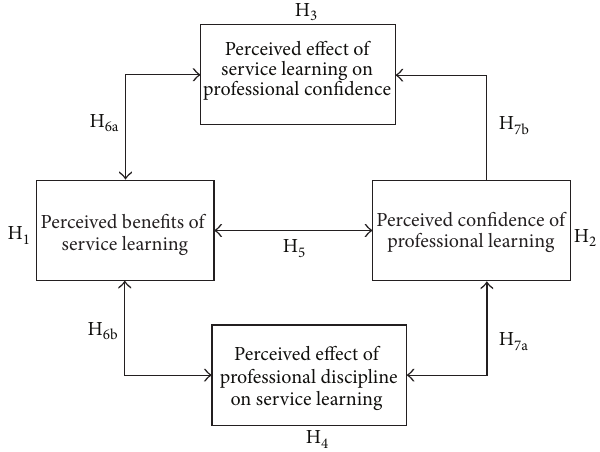
Figure 1: The framework for benefit